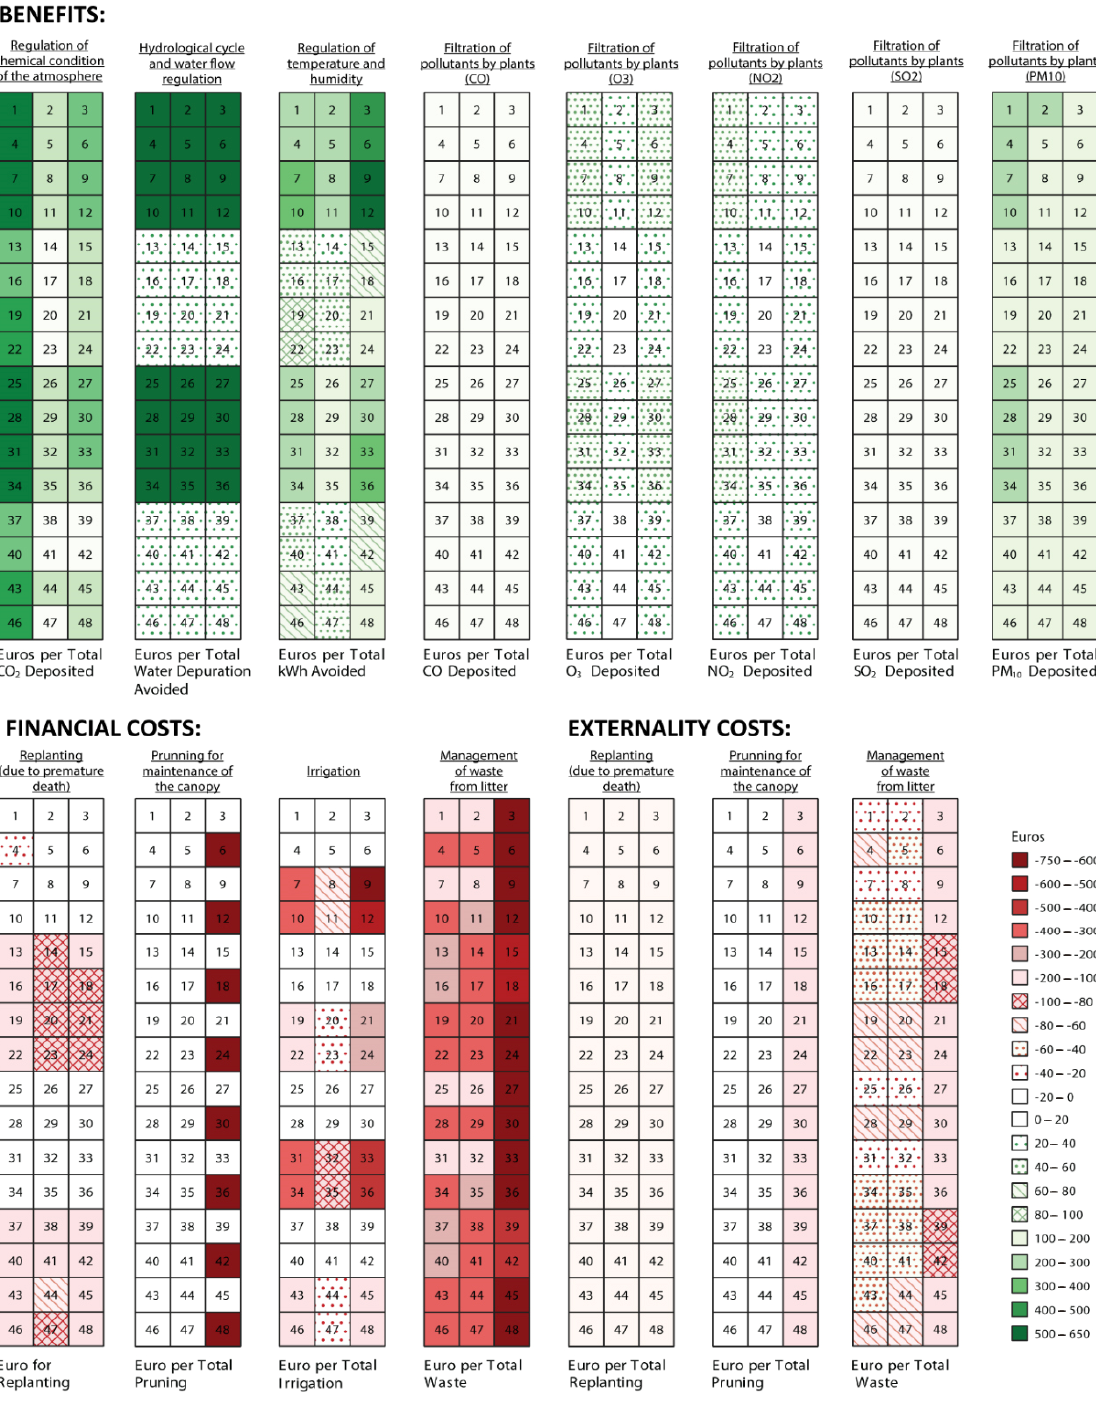
Figure 10. Mean cumulative benefits and costs (externalities and financial) over the operational phase of the 48 urban forest archetypes in monetary units. of the 48 urban forest archetypes in monetary